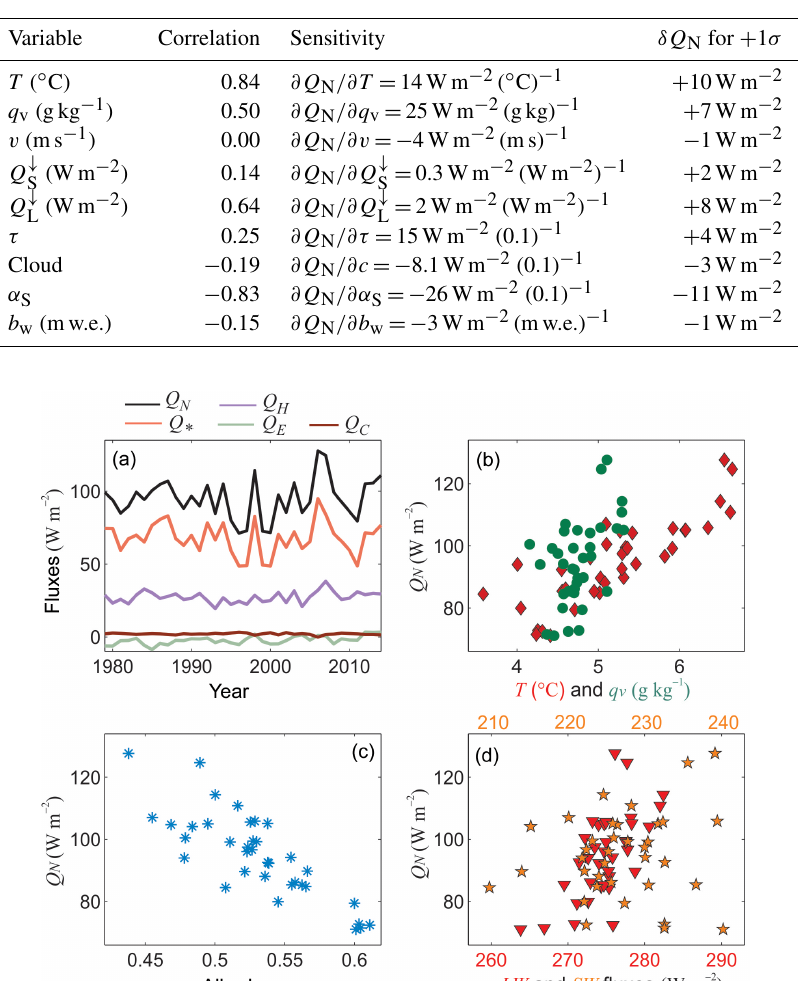
Figure 8. (a Mean summer (JJA) NARR-forced surface energy fluxes at Haig Glacier, 1979–2014. Mean summer net energy as a function of (b) temperature and specific humidity, (c) albedo, and (d) incoming shortwave and longwave radiation. Table 6 gives the associated